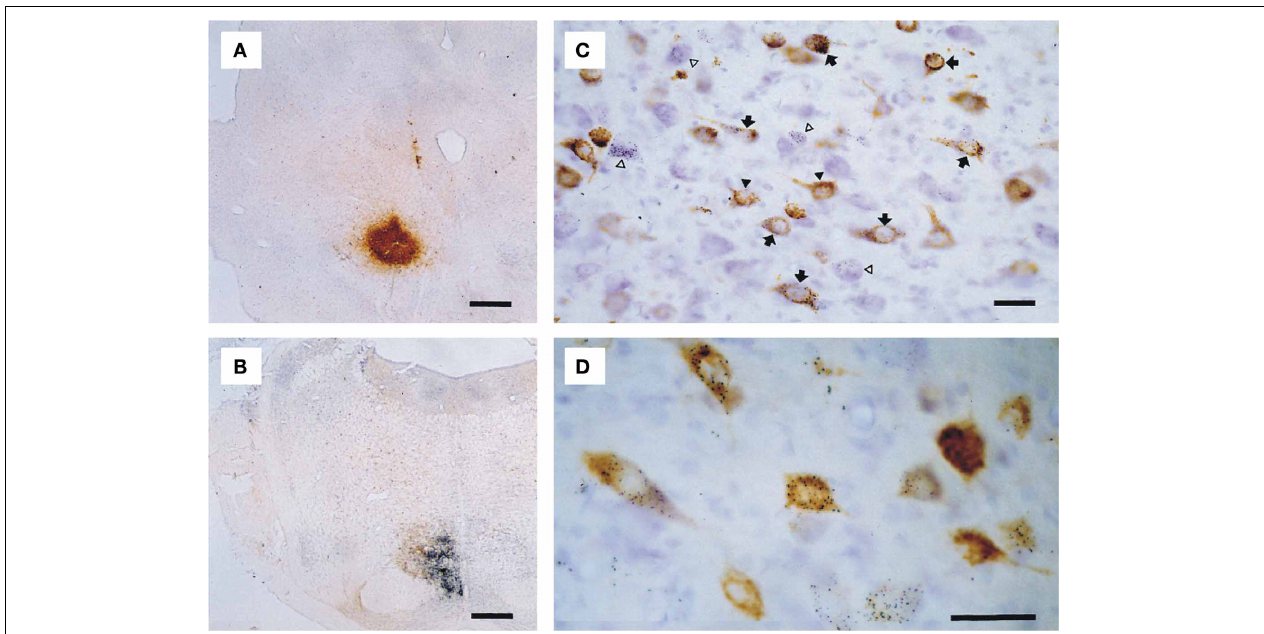
FIGURE 2 | Microphotographs showing examples of double labeling experiment T64. (A) Iontophoretic injection with CTb centered on the RN. (B) Pressure injection with gold-lectin injection centered on the ipsilateral NRTP. (C) Detail of resultant labeling in the contralateral lateral cerebellar nucleus; neurons only labeled with gold-lectin are